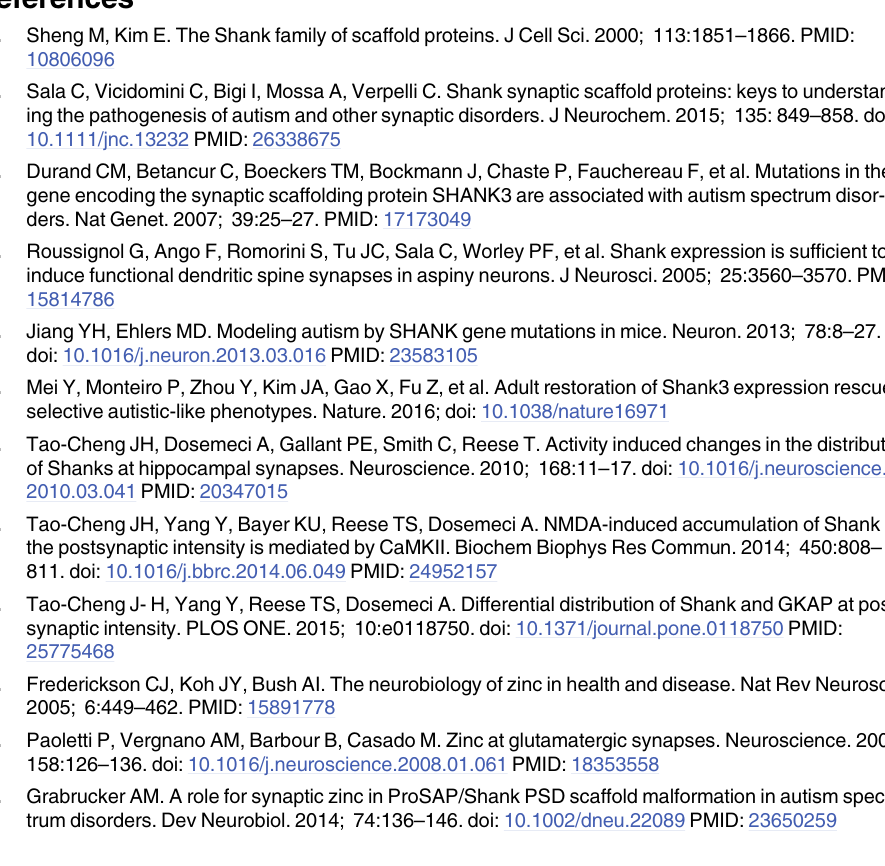
S4 Table. Median distance a of label for Shank3 from the postsynaptic membrane. S5 Table. Effect of APV on labeling intensity of Shank3 under zinc and zinc + NMDA con- ditions. S6 Table. Effect of zinc on labeling intensity for CaMKII. S7 Table. Zinc effect on NMDA-induced increase in labeling intensity for Shank3 after washout of